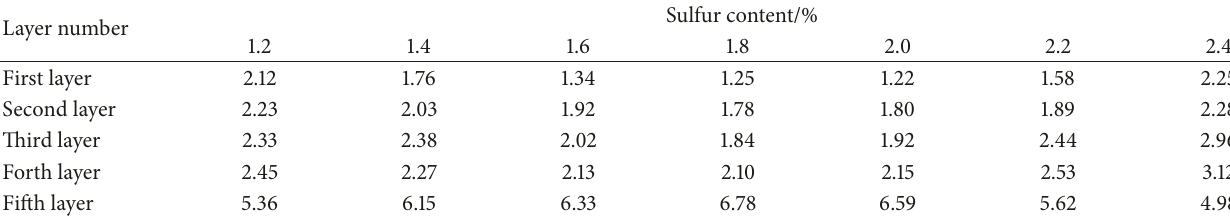
Table 2: Sulfur content of each layer of product.